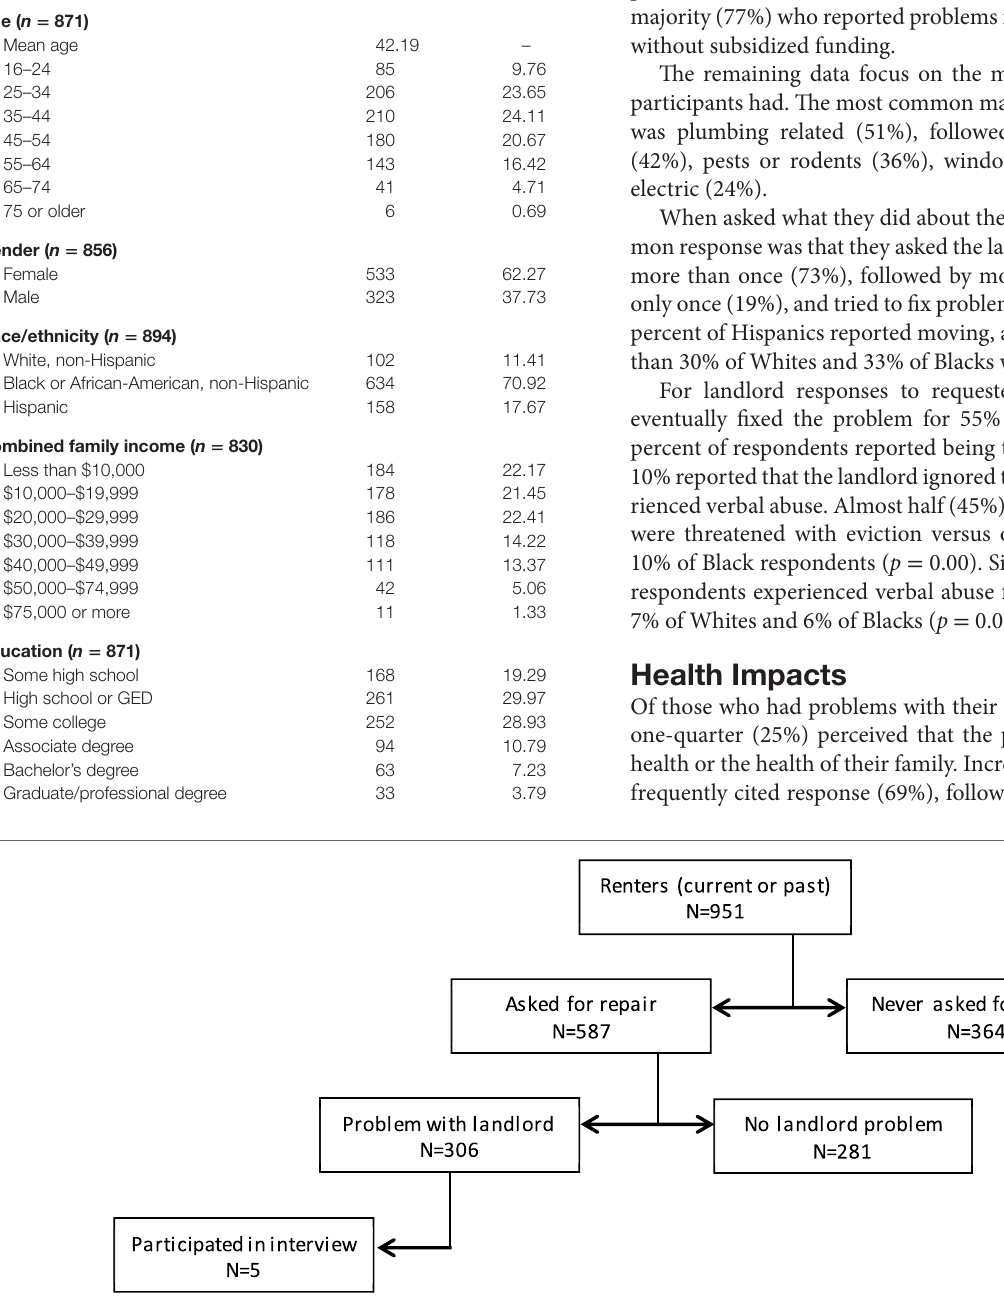
FigUre 1 | survey response frequencies .